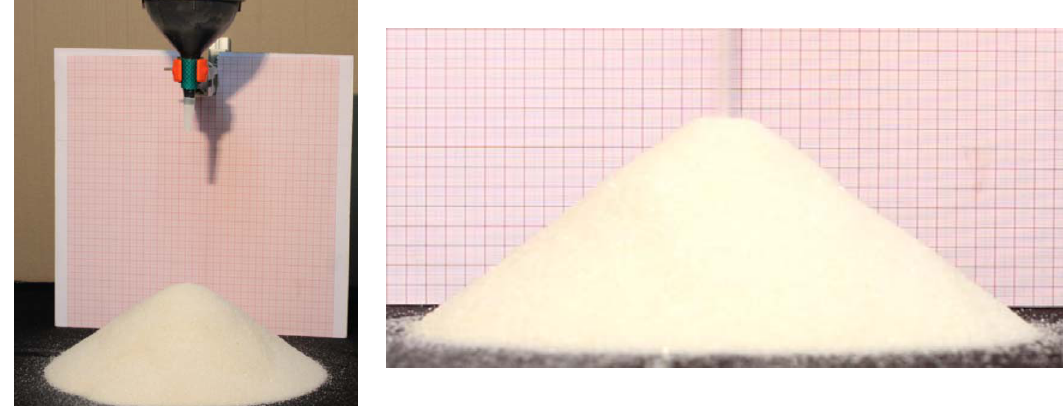
Figure 1. Illustration of sand pile growth ( right ) and description of the apparatus used to measure the heap height ( left ).